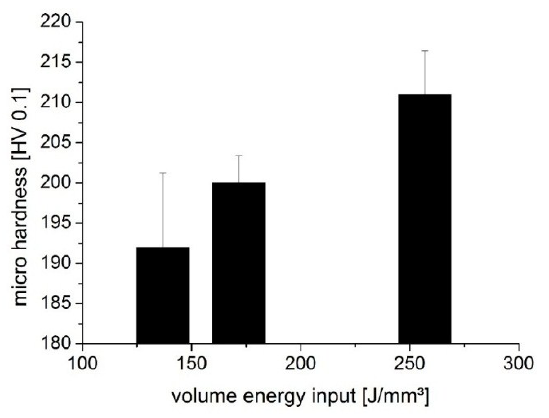
Figure 5. Vickers microhardness data of the samples produced by SLM with different energy input.